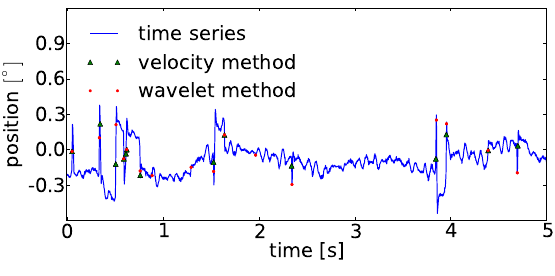
Figure A1 . Detections of microsaccades in an example hor- izontal fixational eye-movement trajectory. The two meth- ods perform quite similar. The wavelet detection method also identifies small scale events, compare e.g., at around